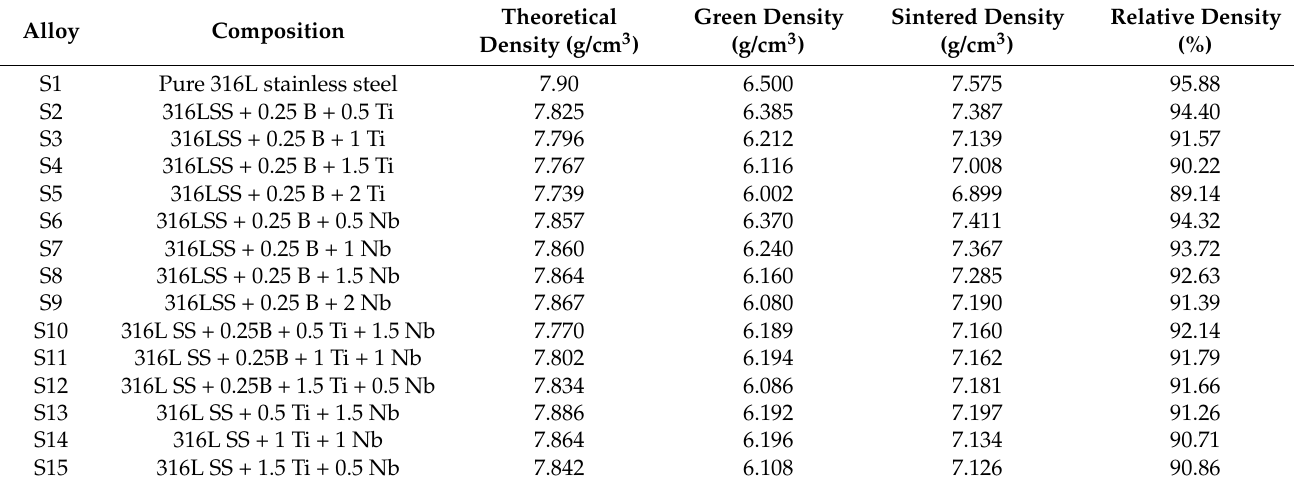
Table 3. Green, sintered, and relative densities for all